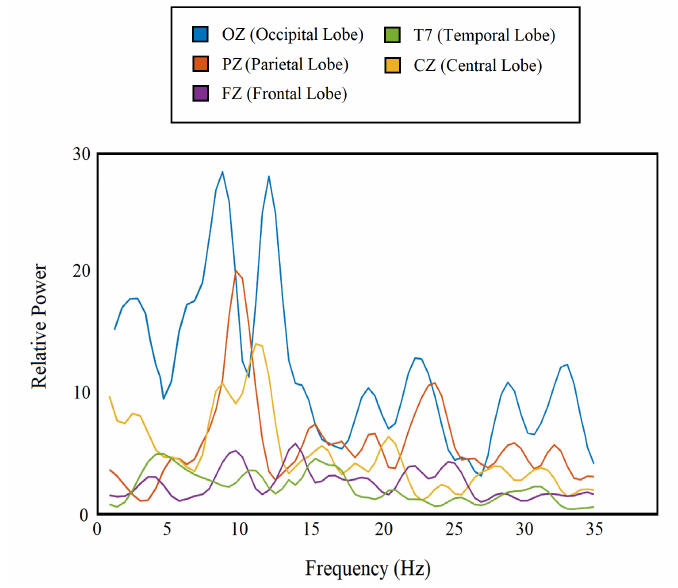
Figure 3. Periodogram of the single-trial EEG for 5 different channels from each